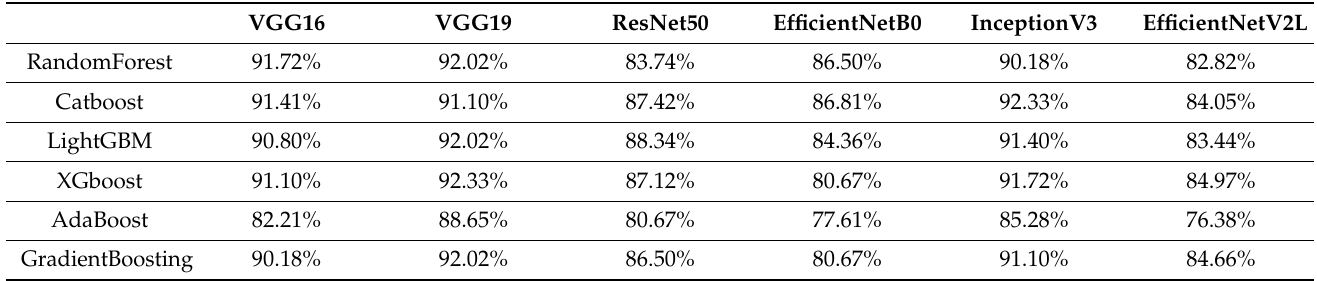
Table A14. Accuracy of each model combination for all green-colored geometries.